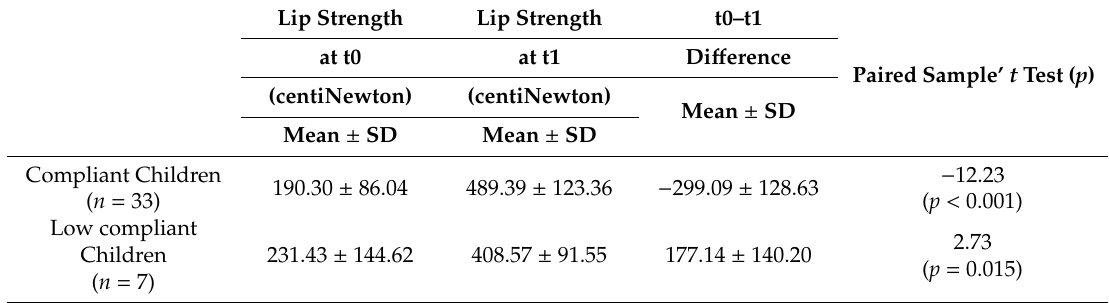
Table 1. Lip strength (measured in centiNewton) at t0 and t1, and evaluation of t0 – t1 differences with